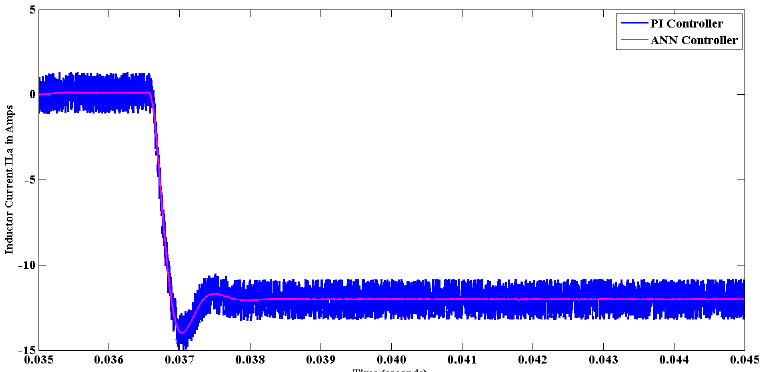
Figure 24. Regulated current step variations in inductor currents during boost mode.